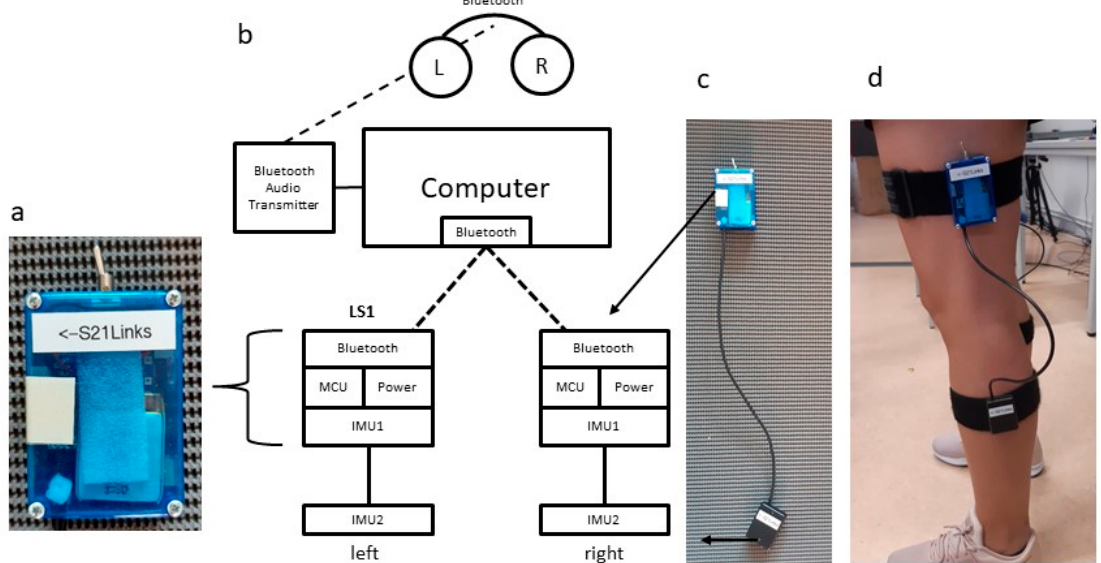
Figure 1. Components of the sofigait system (KMS1). ( a ) LS1 unit consisting of IMU, MCU, Blue- tooth module and battery. ( b ) Schematic illustration of the sofigait system. ( c , d ) One measurement unit and leg